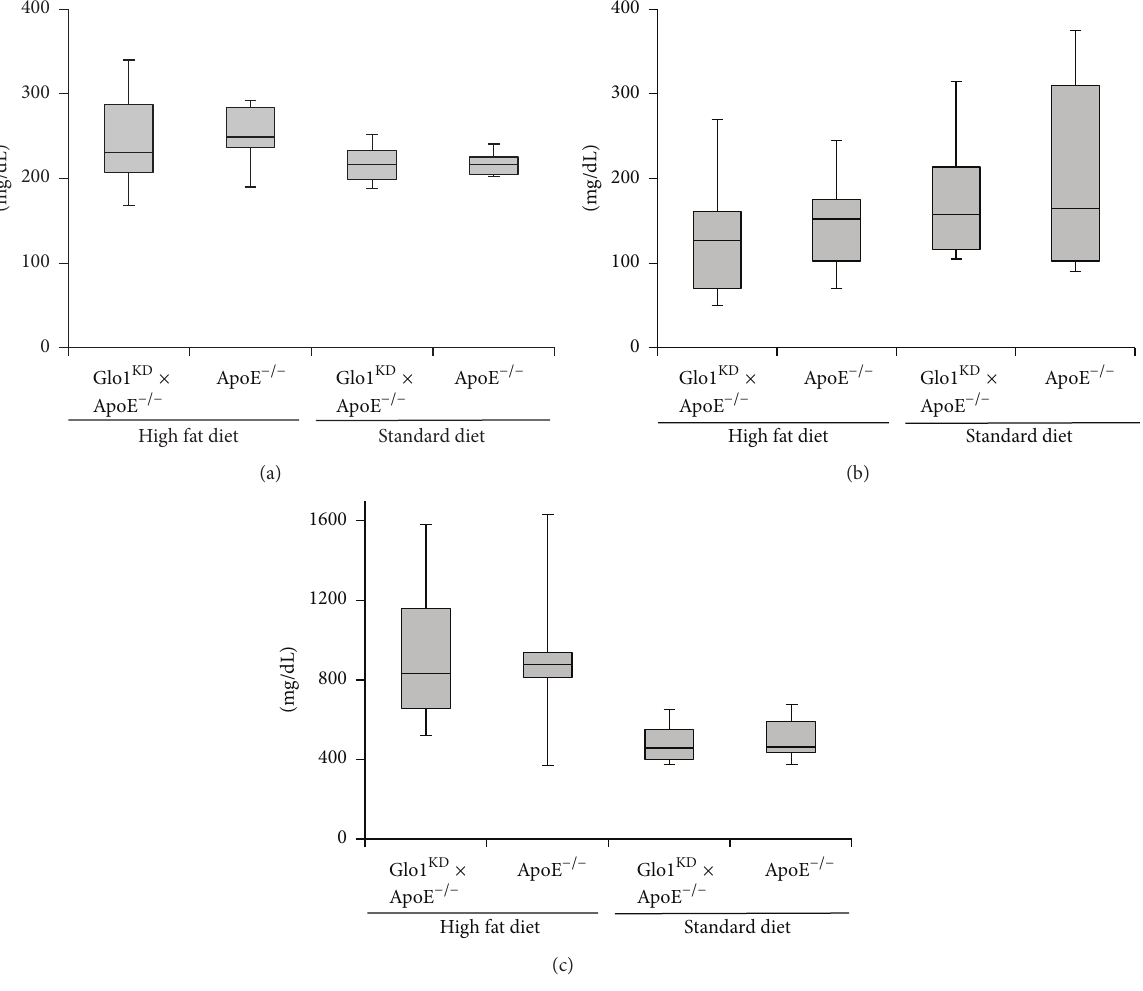
Figure 3: Blood glucose (a), triglycerides (b), and cholesterol (c) were measured in Glo1 KD × ApoE −/− and ApoE −/− mice, both on a high fat and on a standard diet. The Glo1 activity did not have an impact on all parameters